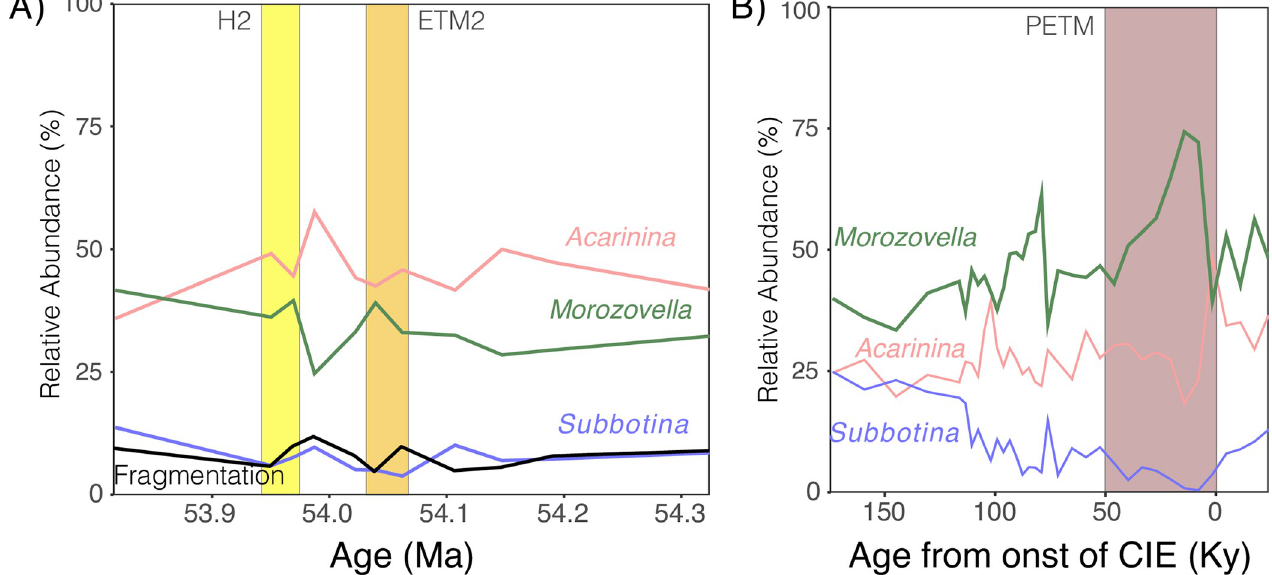
Fig 6. Relative abundance of planktic foraminifera genera (A) before, within, and after the H2 (yellow), ETM2 (orange) and (B) PETM (brown) events. The percent of fragmented tests is shown in black. PETM abundance data from with fragmentation data shown in (Fig 5B of that publication) [43].